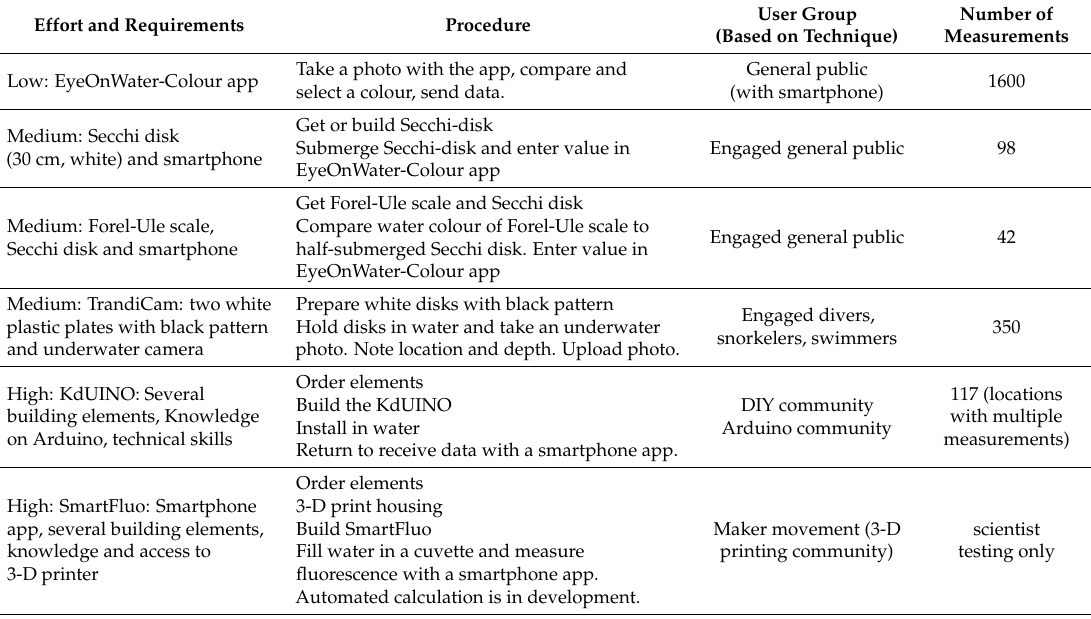
Table 1. Effort, requirements, and user groups for citizen science tools developed in the project Citclops (Status: 8 July